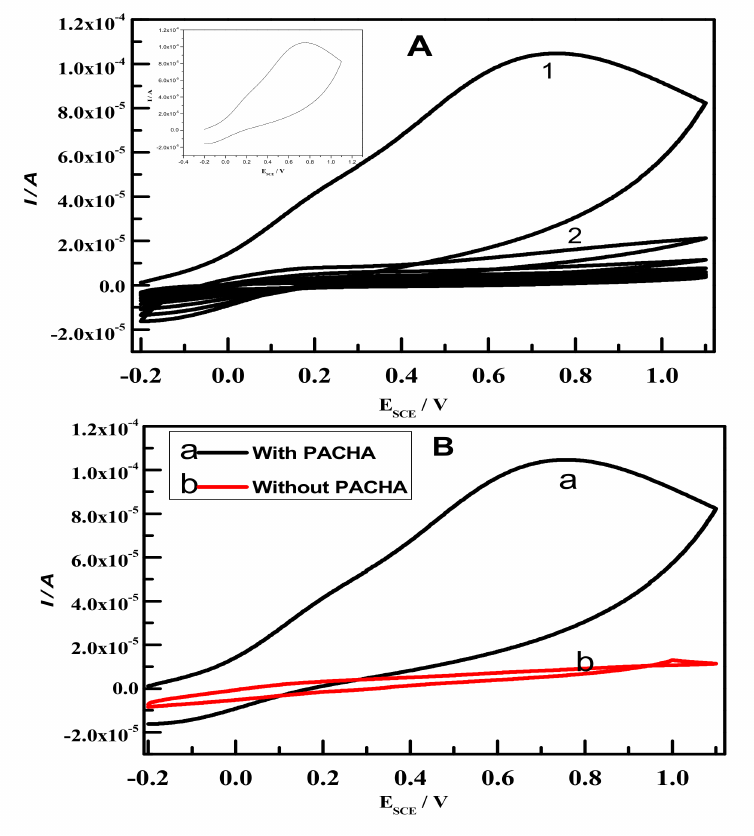
Figure 7. Cyclic voltammograms of ( A ) PACHA coated gold electrode in 0.06 M NaOH + 5 M CH 3 OH at 50 mV/s, (the inset showing the first cycle) and ( B ) CVs curves of methanol electro oxidation recorded on PACHA coated and uncoated gold